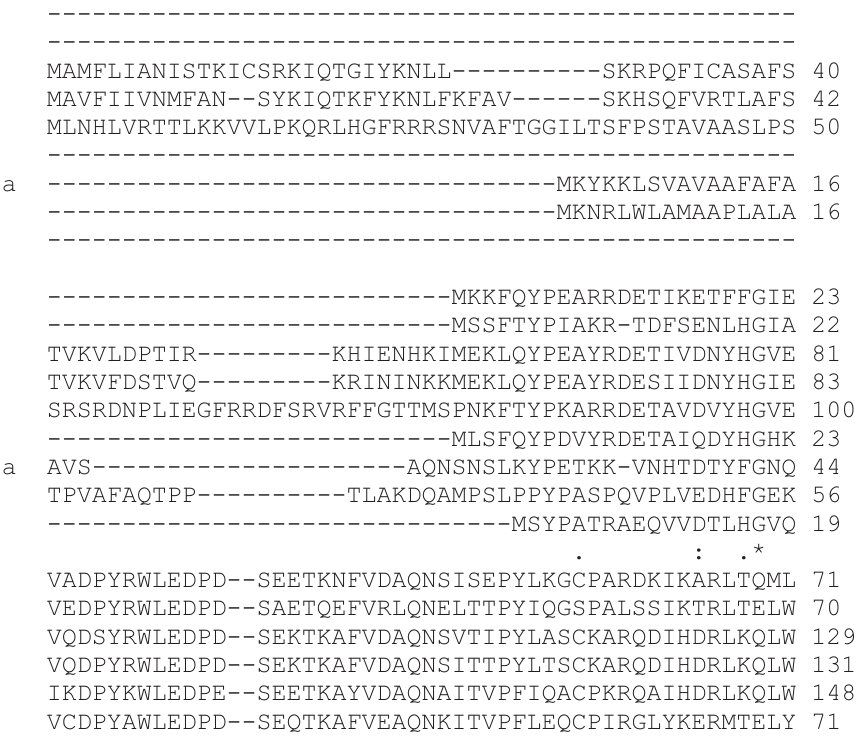
Figure 2. Sunn pest PEP amino acid sequence aligned with PEP sequences of Daphnia pulex (gb|EFX79244.1), Nasonia vitripennis (XP_001603578.2), Bombus terrestris (XP_003394688.1), Apis florea (XP_003691037.1), Sus scrofa (NP_001004050.1), Sphingomonas capsulate (1YR2_A), Elizabethkingia meningoseptica (AAA24925) and Myxococcus xanthus (AAD31004). ClustalW [10] was used to generate the alignment.